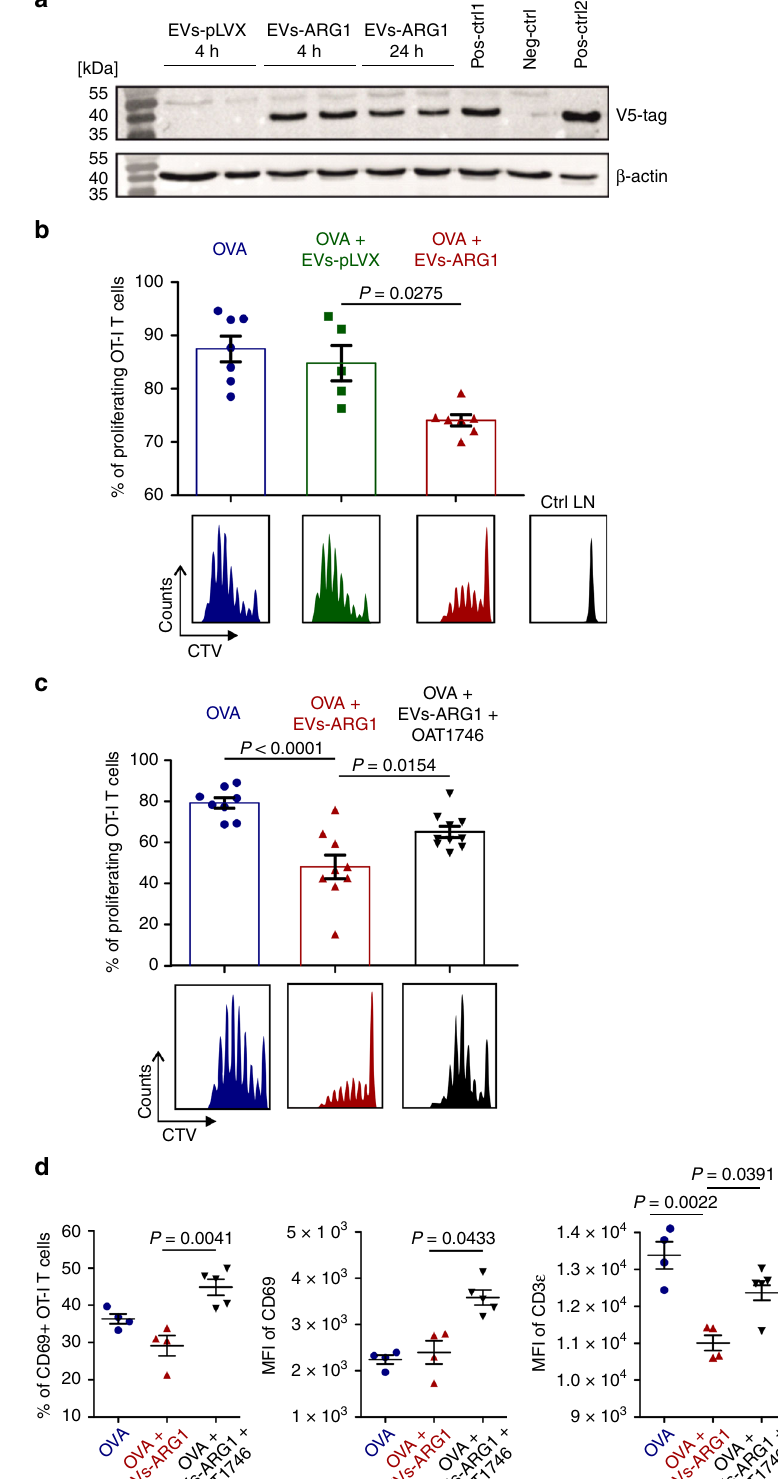
tEVs-mediated suppression of T cell proliferation (Fig. 6c). Flow cytometry analysis of OT-I cells from the draining LNs showed that ARG1 + EVs signi fi cantly decreased the percentage of acti- vated (CD69 + ) OT-I T-cells and downregulated CD3 ε expression in these cells. Upon ARG1 inhibition the CD3 ε levels in OT-I